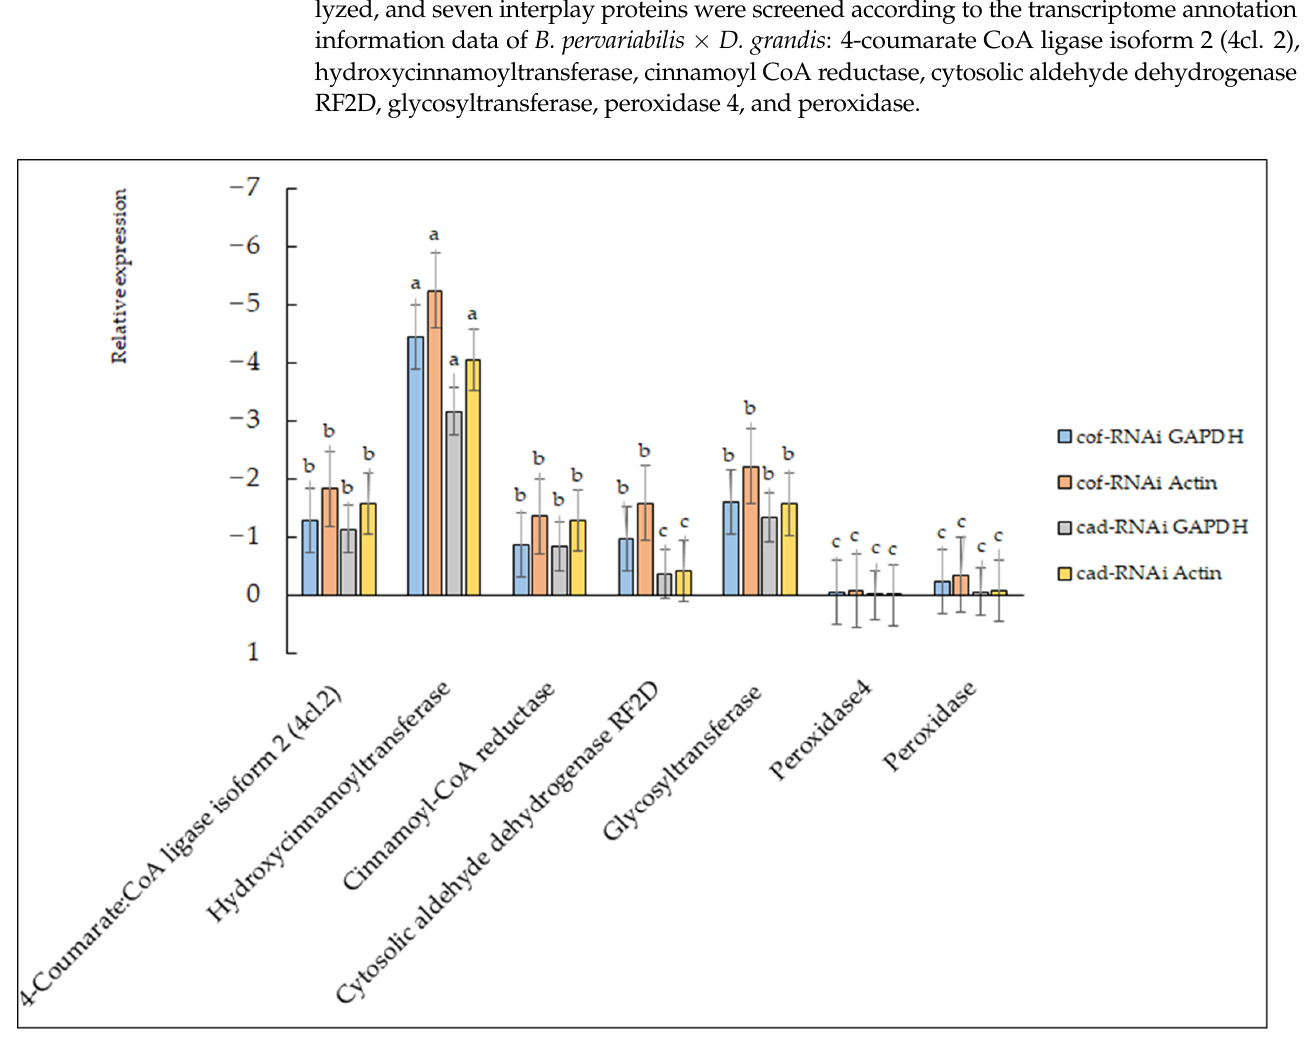
Figure 8. Changes in related protein gene expression levels. There are significant differences in the relative expression of different lowercase letters ( p <